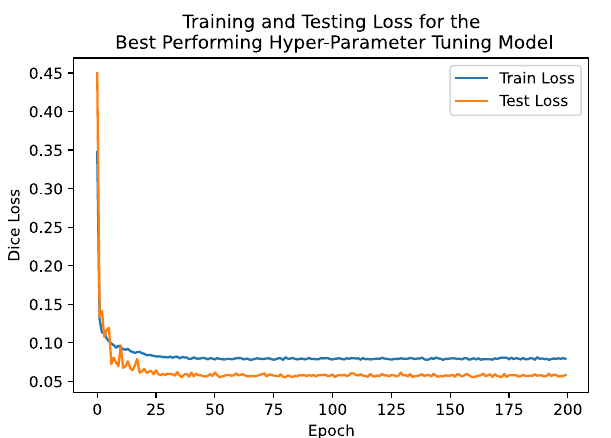
Figure 9. Training and Testing loss of the Hyper-Parameter Tuning model over the course of training. The visible gap between training and testing loss in later epochs may indicate some amount of